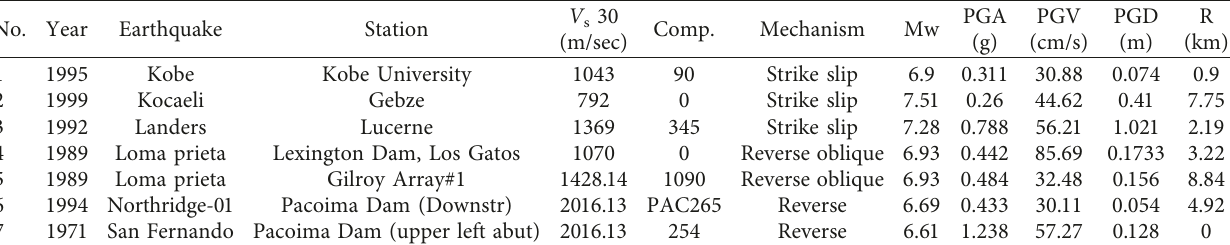
Table 6: Near-field ground motion